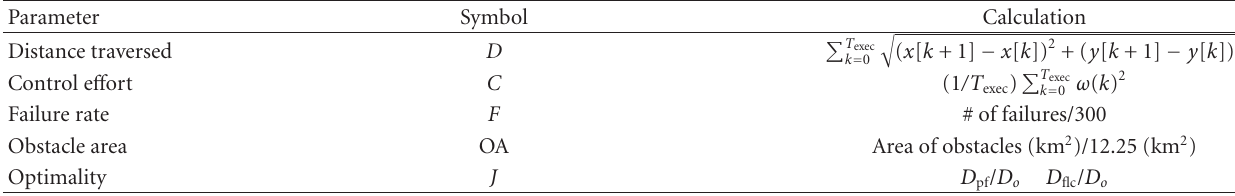
Table 3: Control solution parameters.